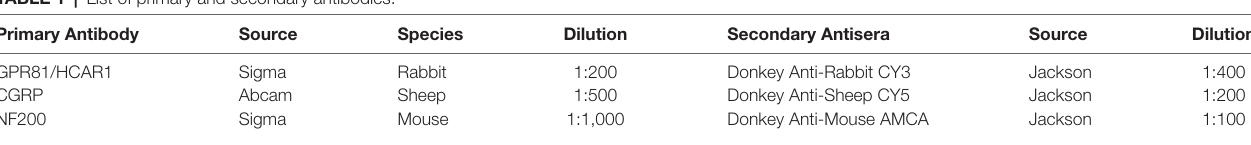
TABLE 1 | List of primary and secondary